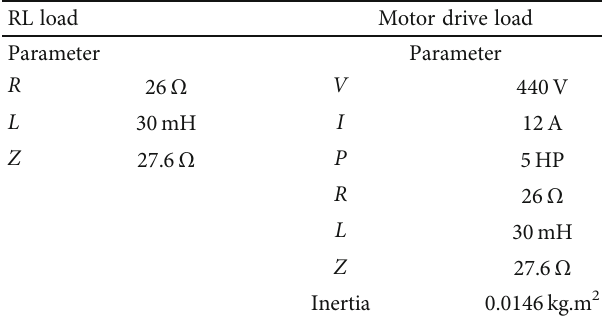
Table 3: Load speci fi cations of three-phase